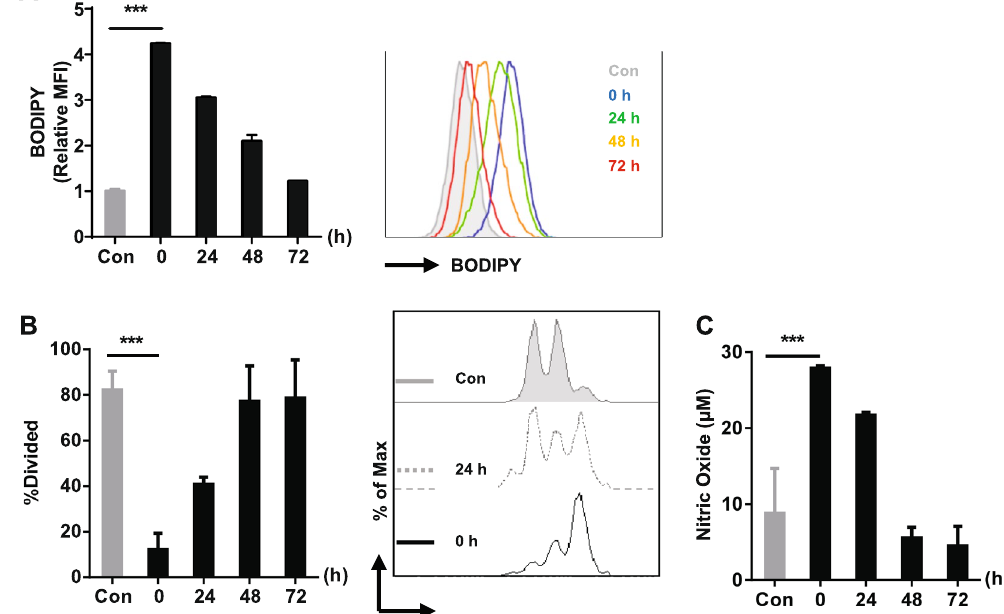
Figure 4. Kinetic of lipid droplets formation and suppressive capacity after sodium oleate treatment. MSC-2 cells were cultured in the presence or absence of sodium oleate (0.2 mM) for 24 h. Cells were washed and left in BSA-medium for up to 72 h and the analysis was performed at the time points indicated. The formation of lipid droplets ( A ) were analyzed by BODIPY staining. The regulatory function of MSC-2 cells from those groups was analyzed via T cell proliferation assay ( B ). Supernatant from the co-culture served for the quantification of NO production ( C ). Shown is the mean ± SD from two to three independent experiments. *** p ≤